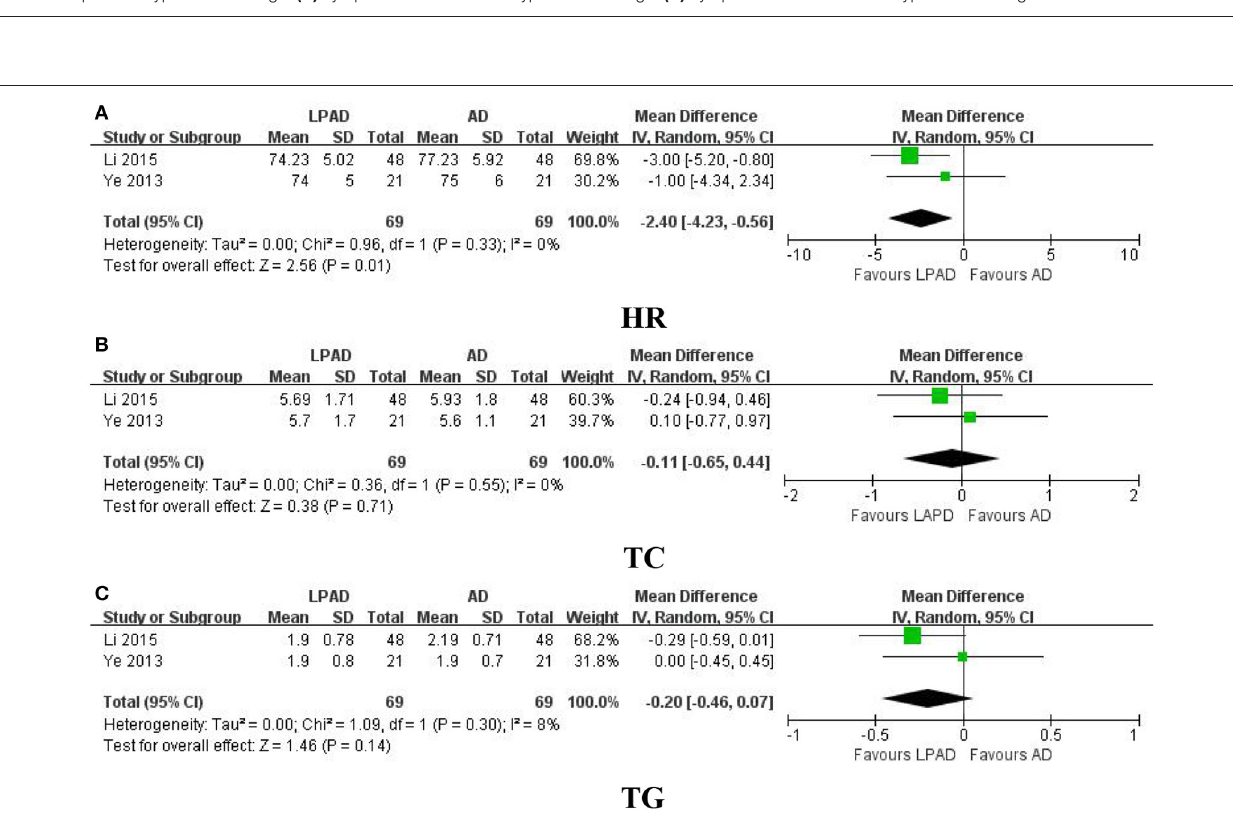
Frontiers in Pharmacology | www.frontiersin.org